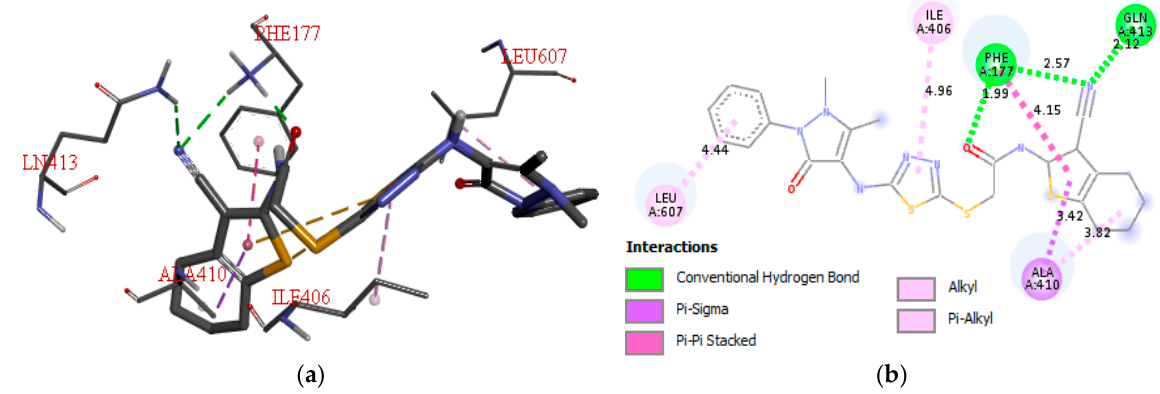
Figure 3. The binding mode compound 3 with 5-LOX enzyme (PDB 3V99): ( a ) 3D visualization; ( b ) Ligand interaction diagram of the title compound 3 with 5-LOX.